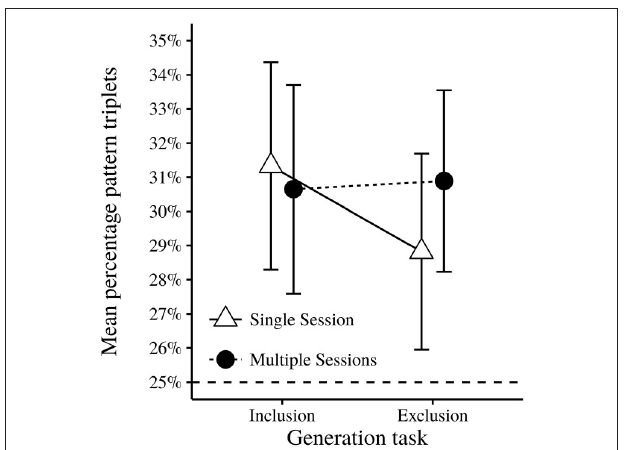
TABLE 7 | Analysis of variance for ASRT generation tasks with proportion pattern trials as dependent variable.